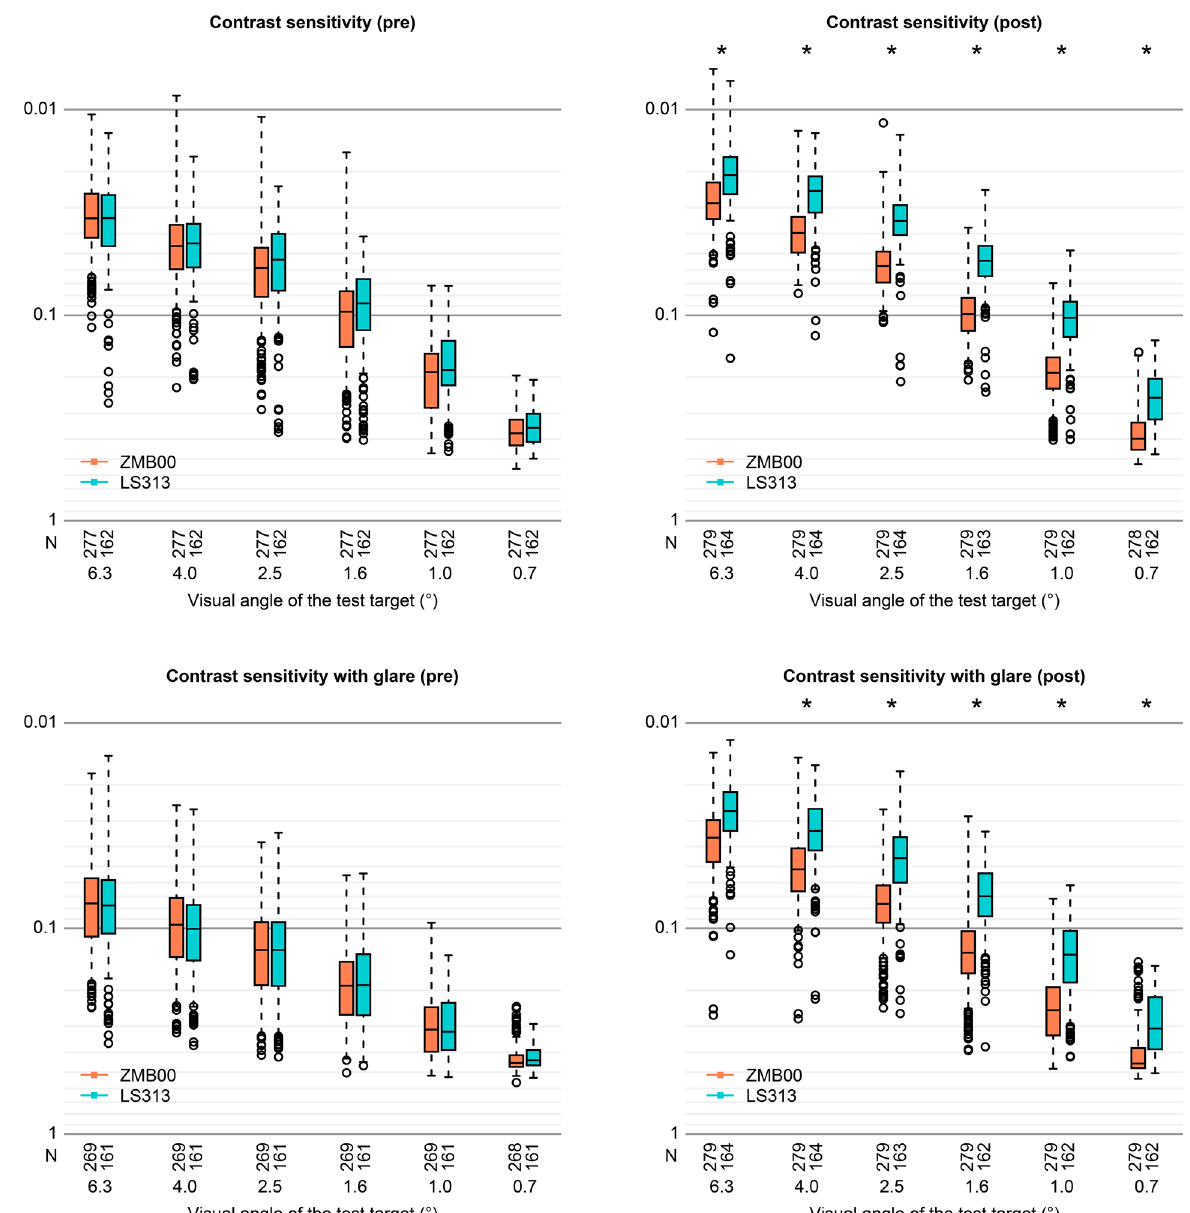
Figure 2. Contrast sensitivity with or without glare (visual angle of the test target: 6.3°/4.0°/2.5°/1.6°/1.0°/0.7°) in the diffractive bifocal (TECNIS ZMB00) and rotationally asymmetric refractive (Lentis Comfort LS-313 MF15) groups before and 10 weeks after surgery in both eyes. In the box-and-whisker plots, the bottom of the box indicates the first quartile, and the top of the box indicates the third quartile. The band inside the box represents the median. To highlight suspected outliers, the upper whisker indicates the maximum or the third quartile + 1.5 × IQR, while the lower whisker indicates the minimum or the first quartile-1.5 × IQR. Each parameter was adjusted by multiple linear regression with the explanatory variables in Table 1. The two-sided Wald test was applied to evaluate the significance of differences between the two groups, and the significance level was set to 0.0083 after Bonferroni’s